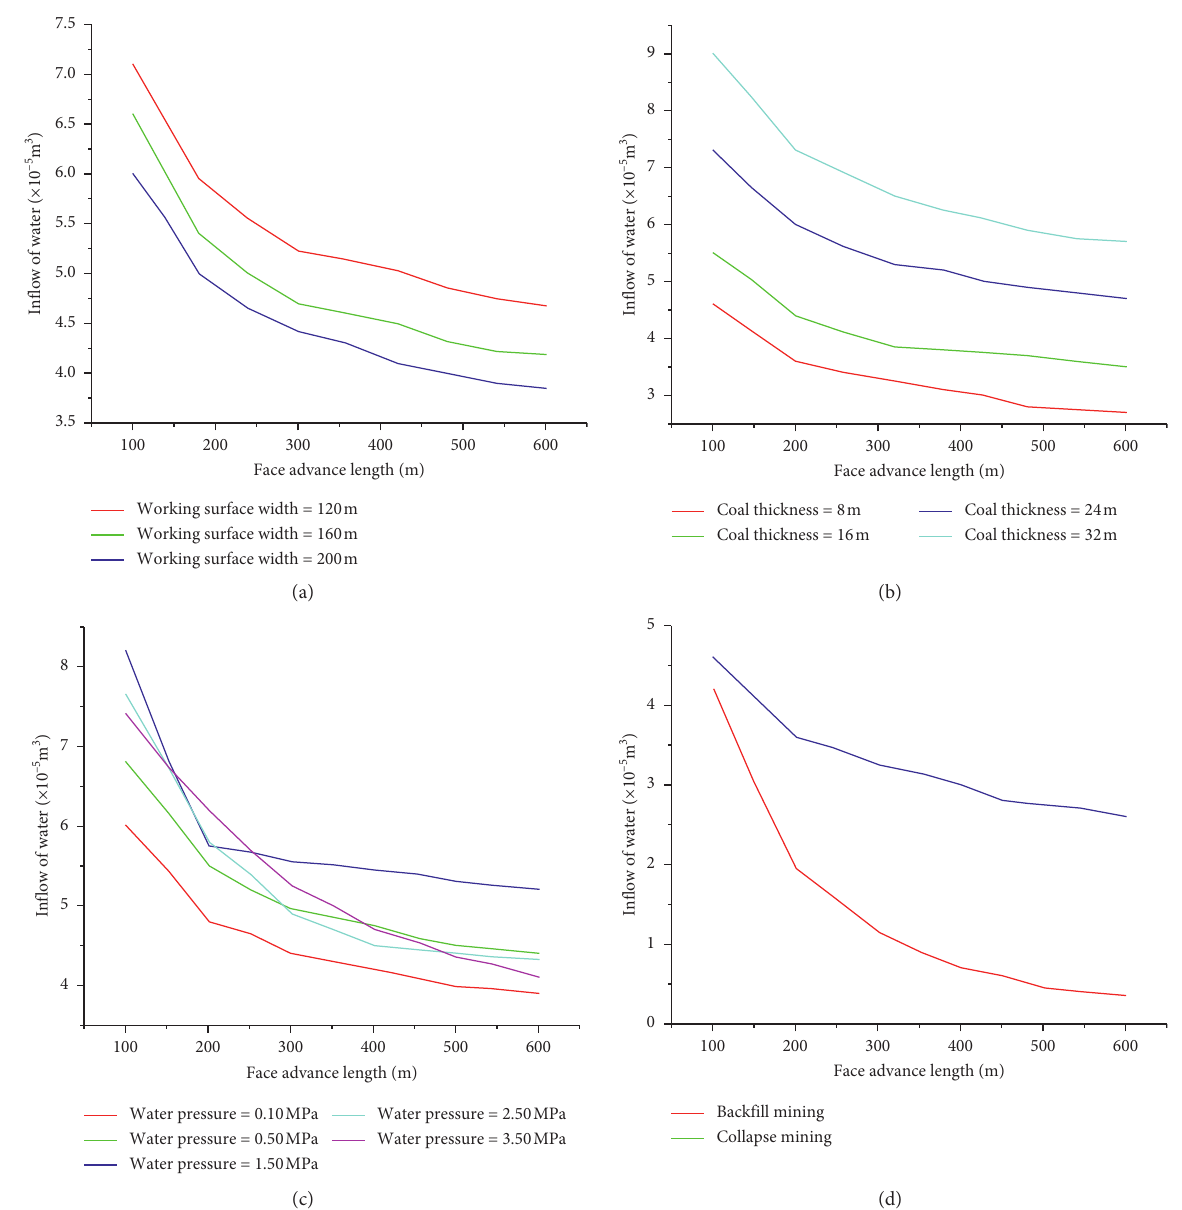
Figure 5: Inrush water flow of working face under different conditions. (a) Inrush water flow of working faces of different width. (b) Inrush water flow of working faces of different coal thickness. (c) Inrush water flow of working faces under different. (d) Inrush water flow of working face under